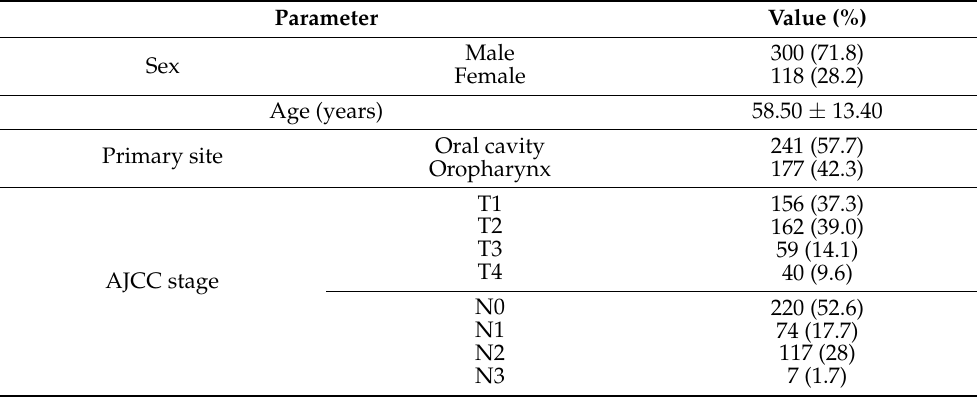
Table 1. Patient characteristics, treatment modalities, and outcomes ( n =